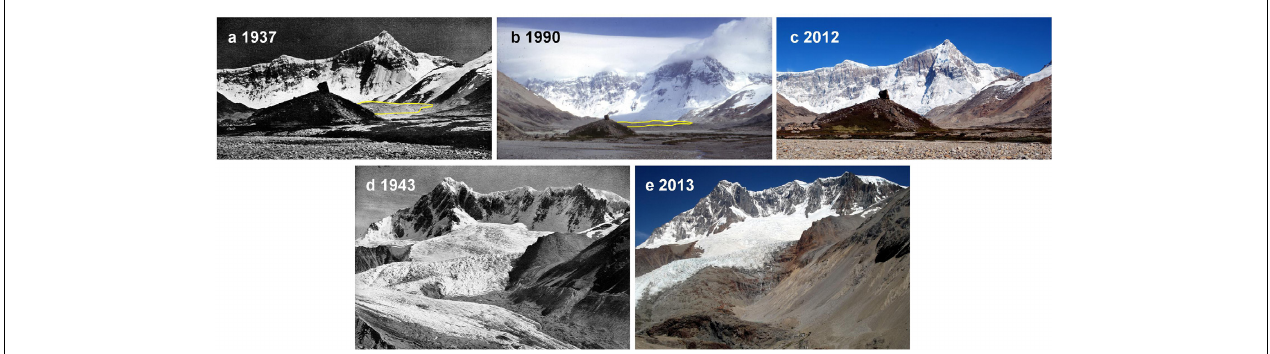
FIGURE 10 | Paired photographs of the Río Lácteo ( a–c , in yellow line) and Río Oro (d , e) glaciers. The 1937 and 1943 shots are taken from De Agostini (1945) and the 1990 photo is courtesy of John Mercer.